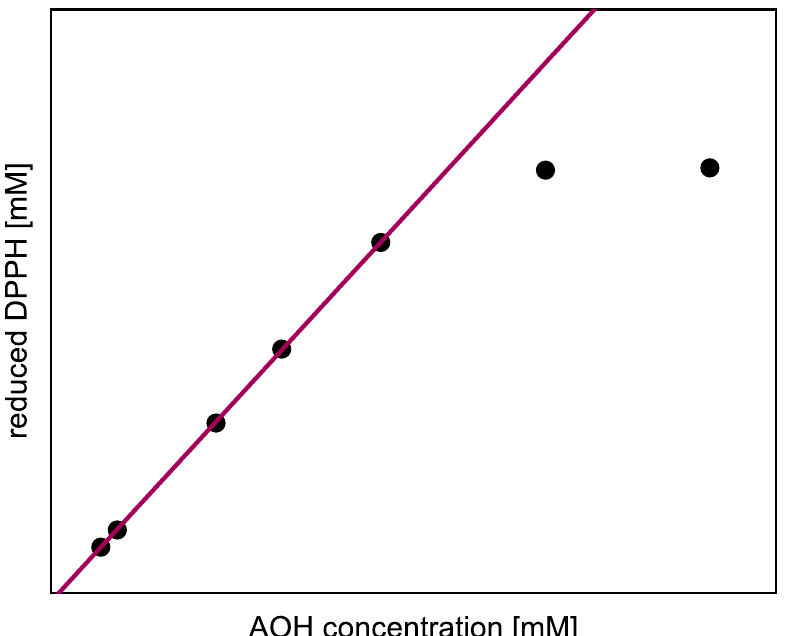
Figure 2. Schematic example of the linear regression for the evaluation of the total stoichiometry of all